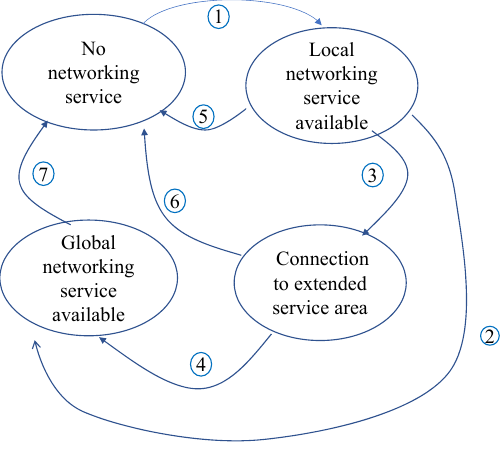
Figure 9. State machine of a